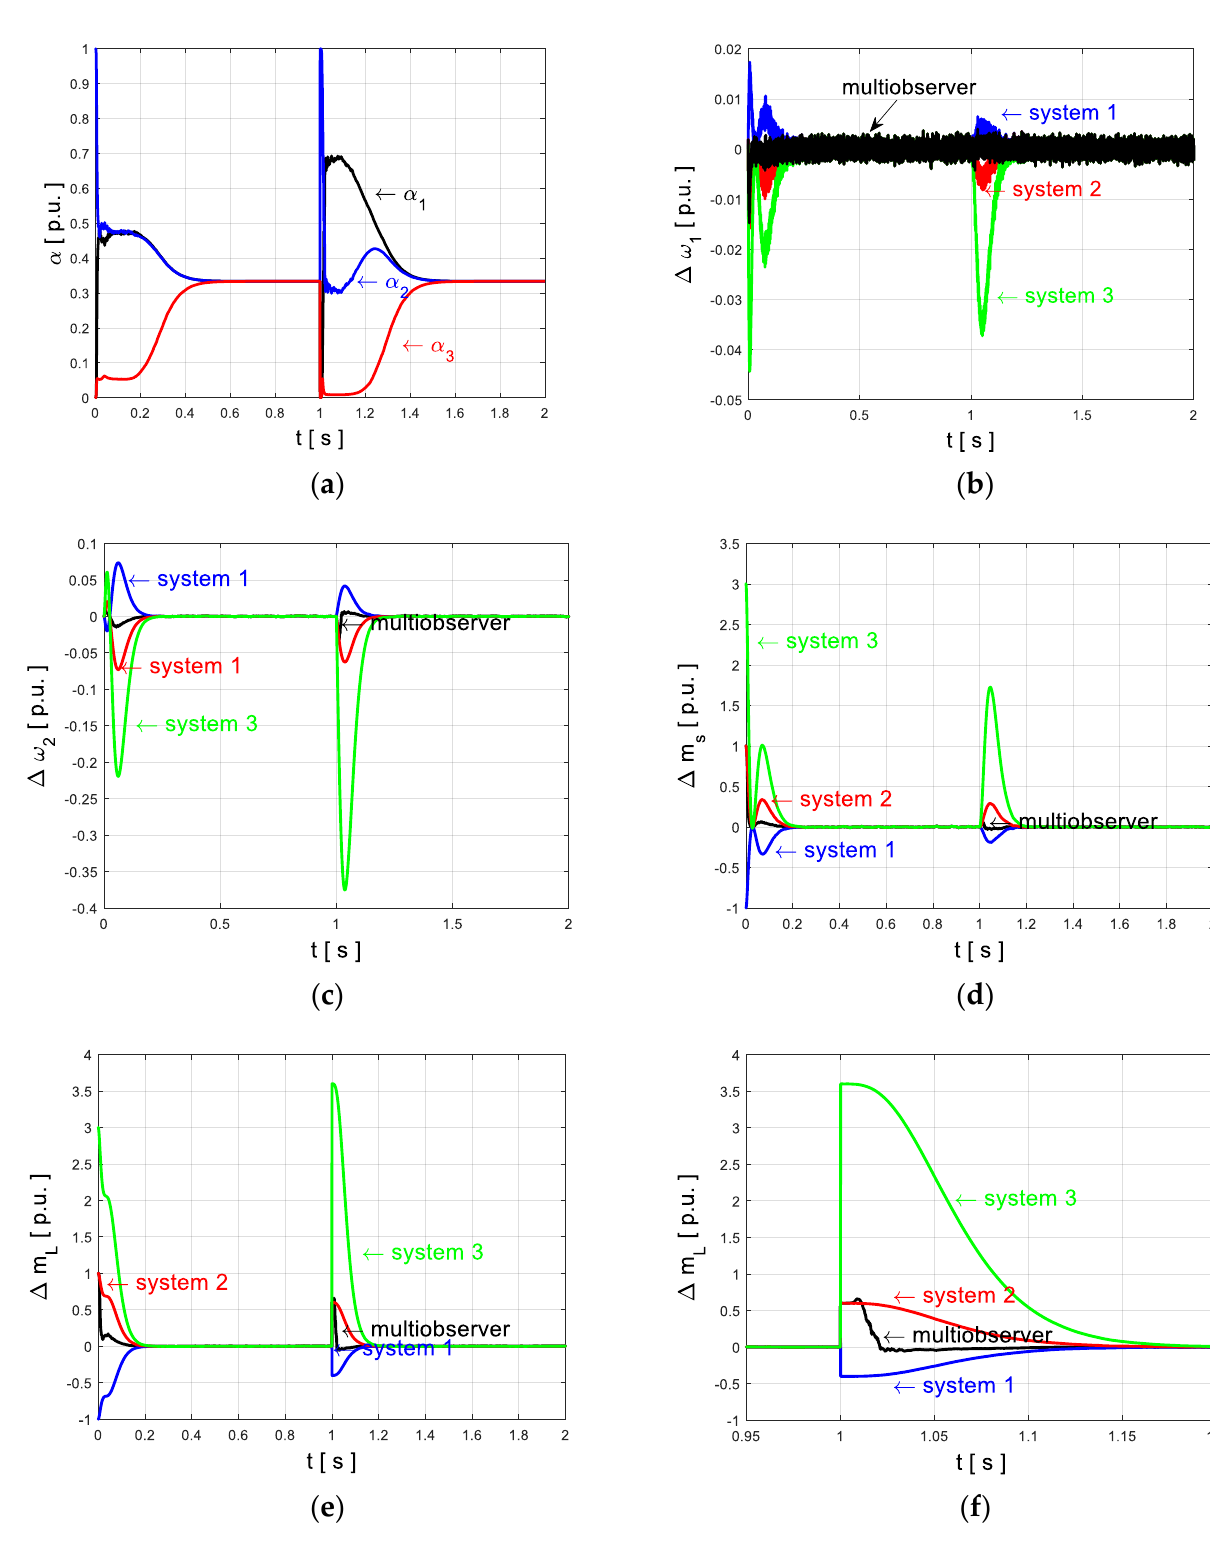
Figure 6. Transients of the observer’s weights α ( a ) and estimation errors for: motor ( b ) and load speeds ( c ), shaft ( d ) and load torques ( e ) and fragments of load torque ( f ) for multilayer observer working in open-loop system, second version – simulation.